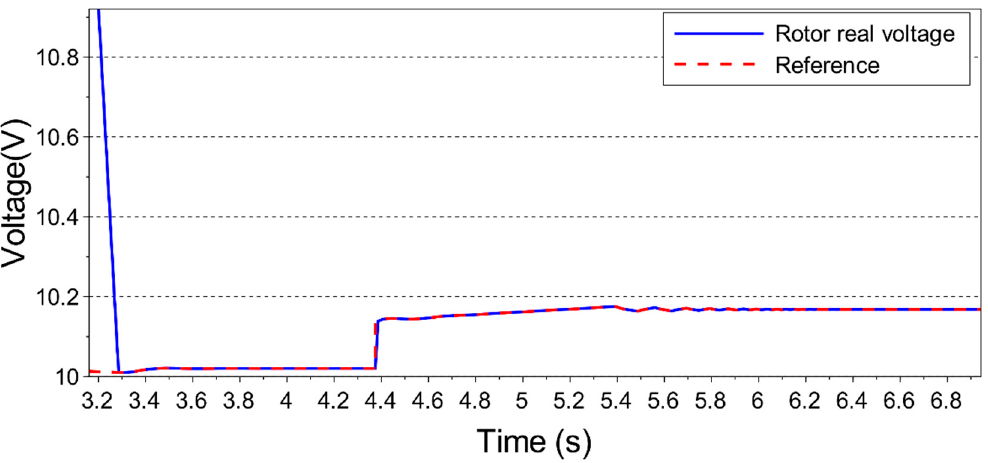
Figure 15. V Rr reference Figure 15. (cid:1848) (cid:3019)(cid:3045) reference update.